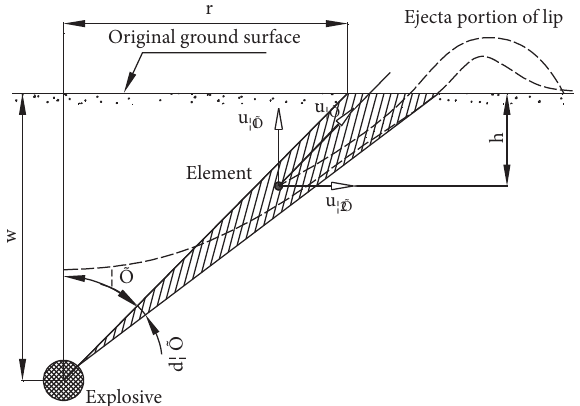
Figure 9: Schematic diagram of a debris element being thrown out of the